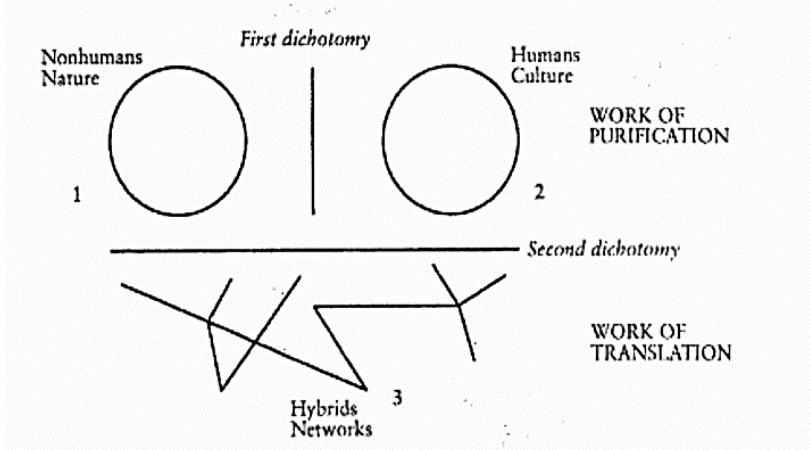
Fig. 3 Displacing the dichotomy and separation between nonhumans and humans through the work of translation (Latour, 1993, p. 11)